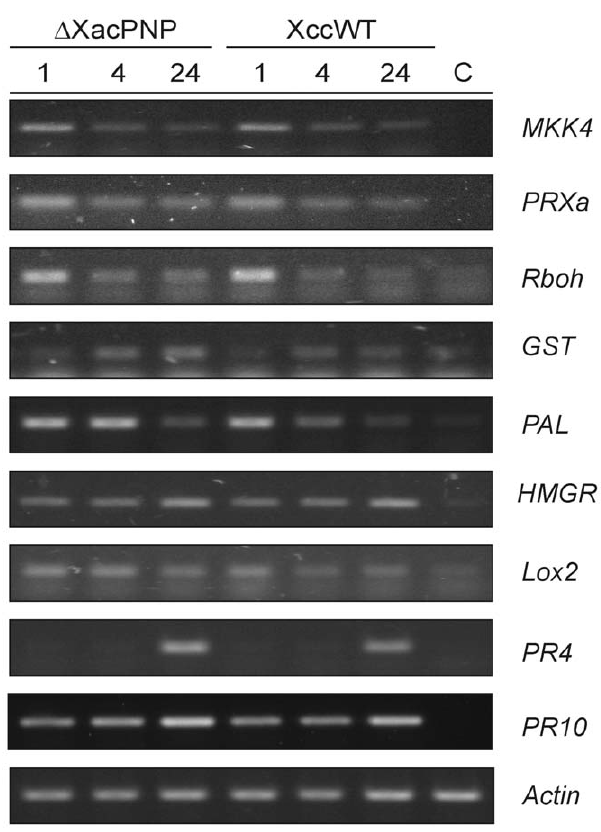
Figure 4. Expression of defense-related genes in citrus leaves infected with D XacPNP and Xcc (XccWT). RT-PCR were performed in RNA samples taken at 1, 4 and 24 hpi. MKK4, MAP kinase kinase 4; PRXa, peroxidorexin; Rboh, NADPH oxidase; GST, glutathione-S- transferase; PAL, phenylalanine ammonia lyase; HMGR, 3-hydroxy- methylglutaryl CoA reductase; Lox2, lipoxygenase 2. As controls (C) leaves infiltrated with 10 mM MgCl 2 at the times stated were analyzed. While in the figure the control at 1 hpi is shown, similar results were obtained for 4 and 24 hpi.